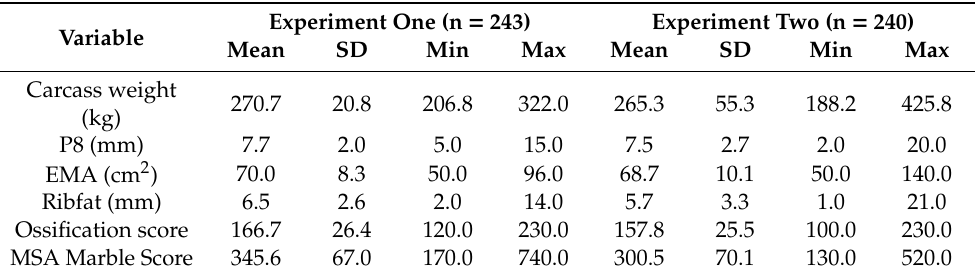
Table 3. Summary of Meat Standards Australia (MSA) grading characteristics by experiment. Variable